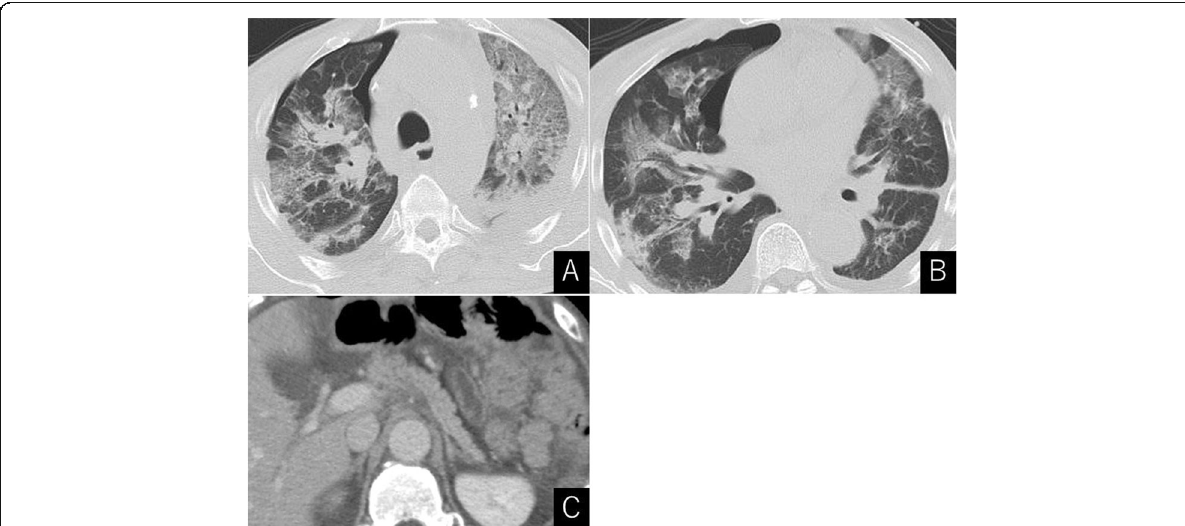
Fig. 1 CT scan showed severe bilateral pulmonary edema. Small amount of iatrogenic pneumothorax was secondary to thoracentesis ( a , b ). Pancreas was intact ( c